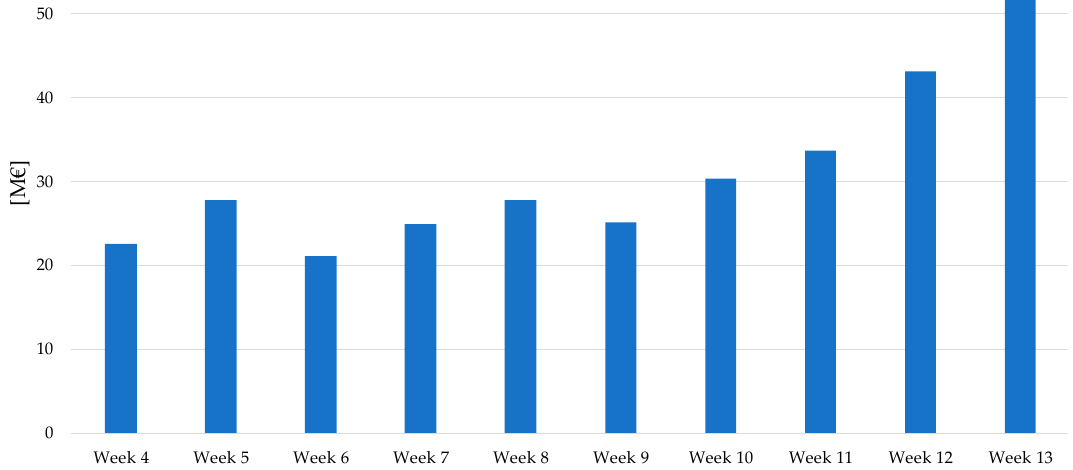
Figure 23. Weekly system costs paid by the Italian transmission system operator (TSO) for ancillary services.